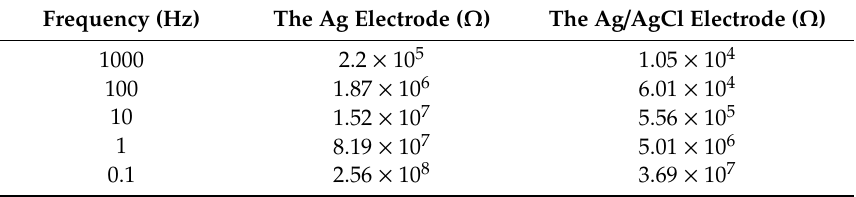
Table 1. The impedances of the Ag electrode and modified Ag/AgCl electrode at different frequencies.